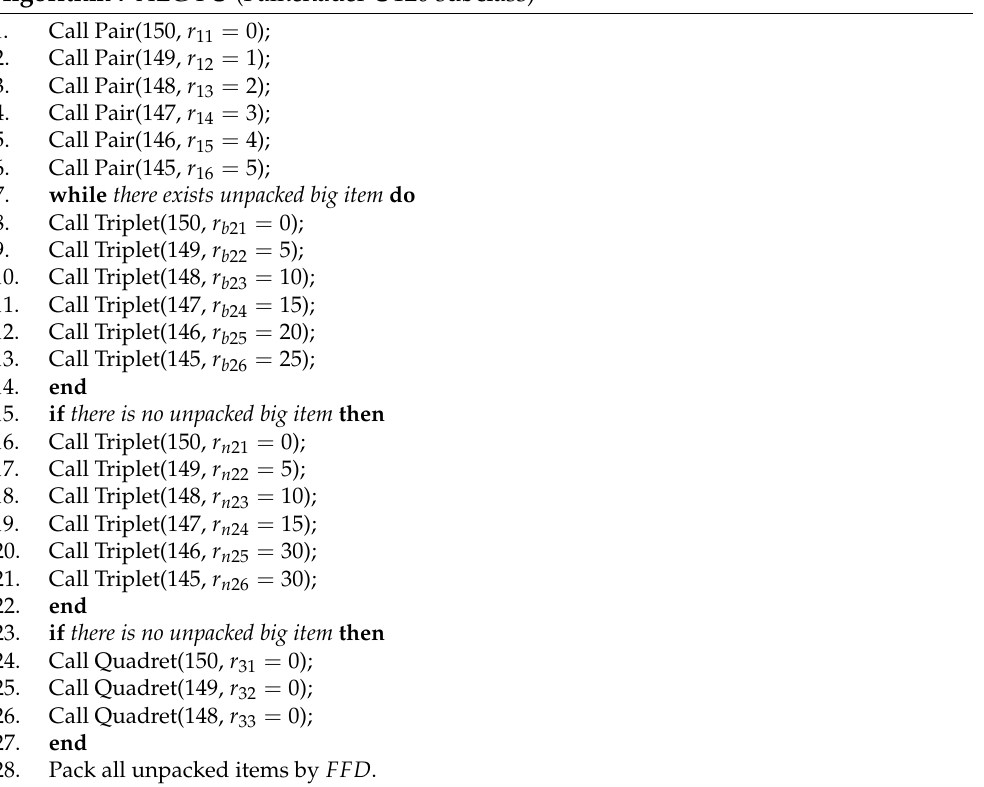
Algorithm 7 ALG FU (Falkenauer U120 subclass)